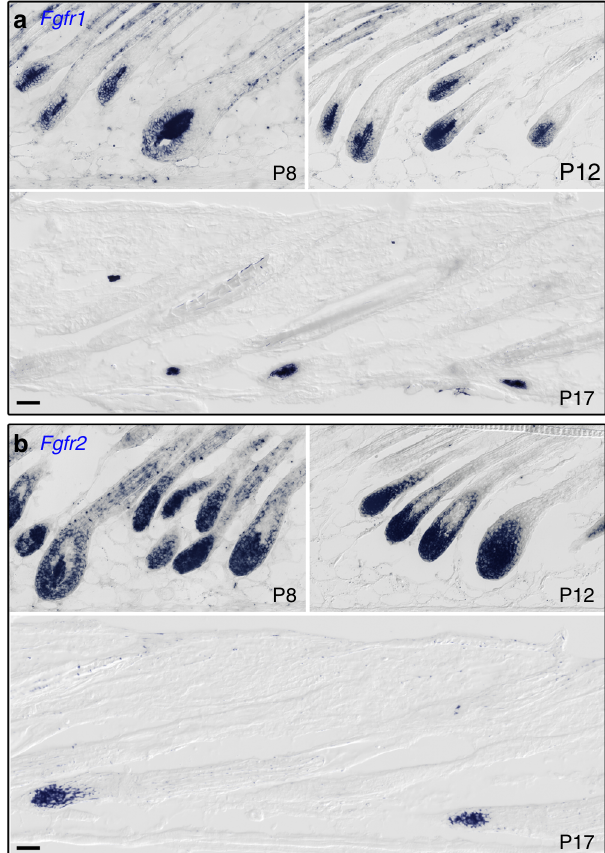
Fig. 1 Fgfr1 and Fgfr2 are expressed in the DP throughout the anagen and catagen phase. In situ hybridizations for Fgfr1 ( a ) and Fgfr2 ( b ) are shown. Note that the transcripts (blue) for both receptors become restricted to the DP during catagen (P17). All images were taken within the same scale and chronologically ordered clockwise. Unpigmented FVB mice were used. n > 3 mice per time point. Scale bar, 50 μ